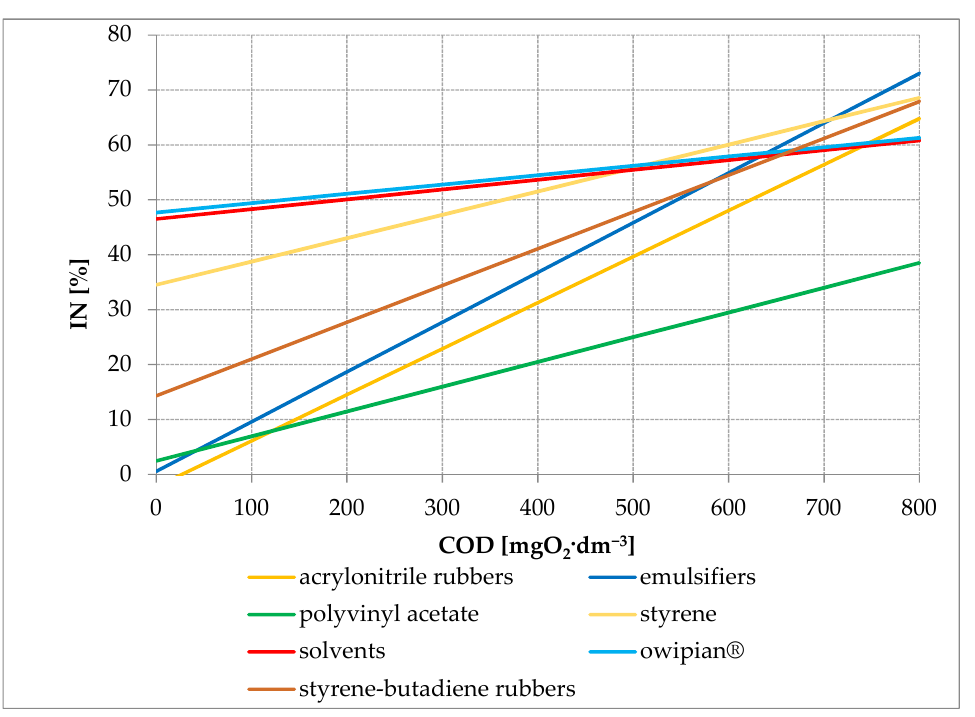
Figure 3. The course of the regression line showing the effect of the COD value in industrial wastewater on the nitrification inhibition expressed by the value of the IN parameter.